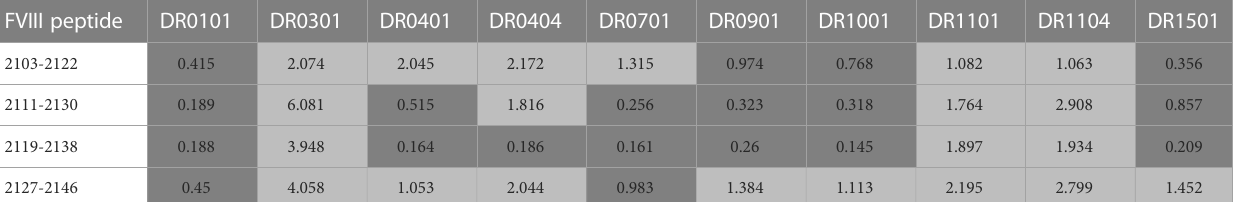
TABLE 2B Predicted binding af fi nities (IC50 values)* of FVIII exon 22-23 junction peptides. FVIII